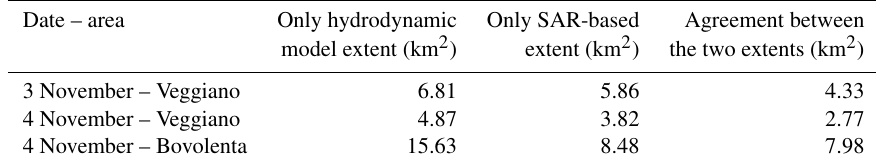
Table 2. Flood extent cross comparison between SAR-based extent and hydrodynamic model-based extent. Date – area